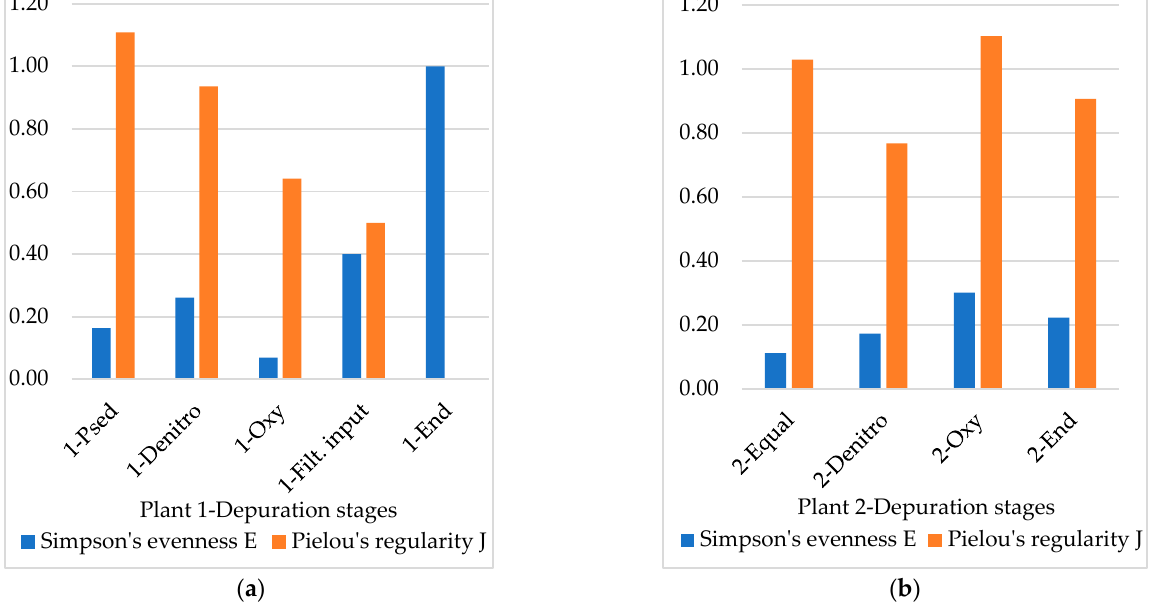
Figure 5. Simpson’s evenness and Pielou’s regularity at an Order scale in different depuration stages of Plant 1 ( a ) and Plant 2 ( b ).